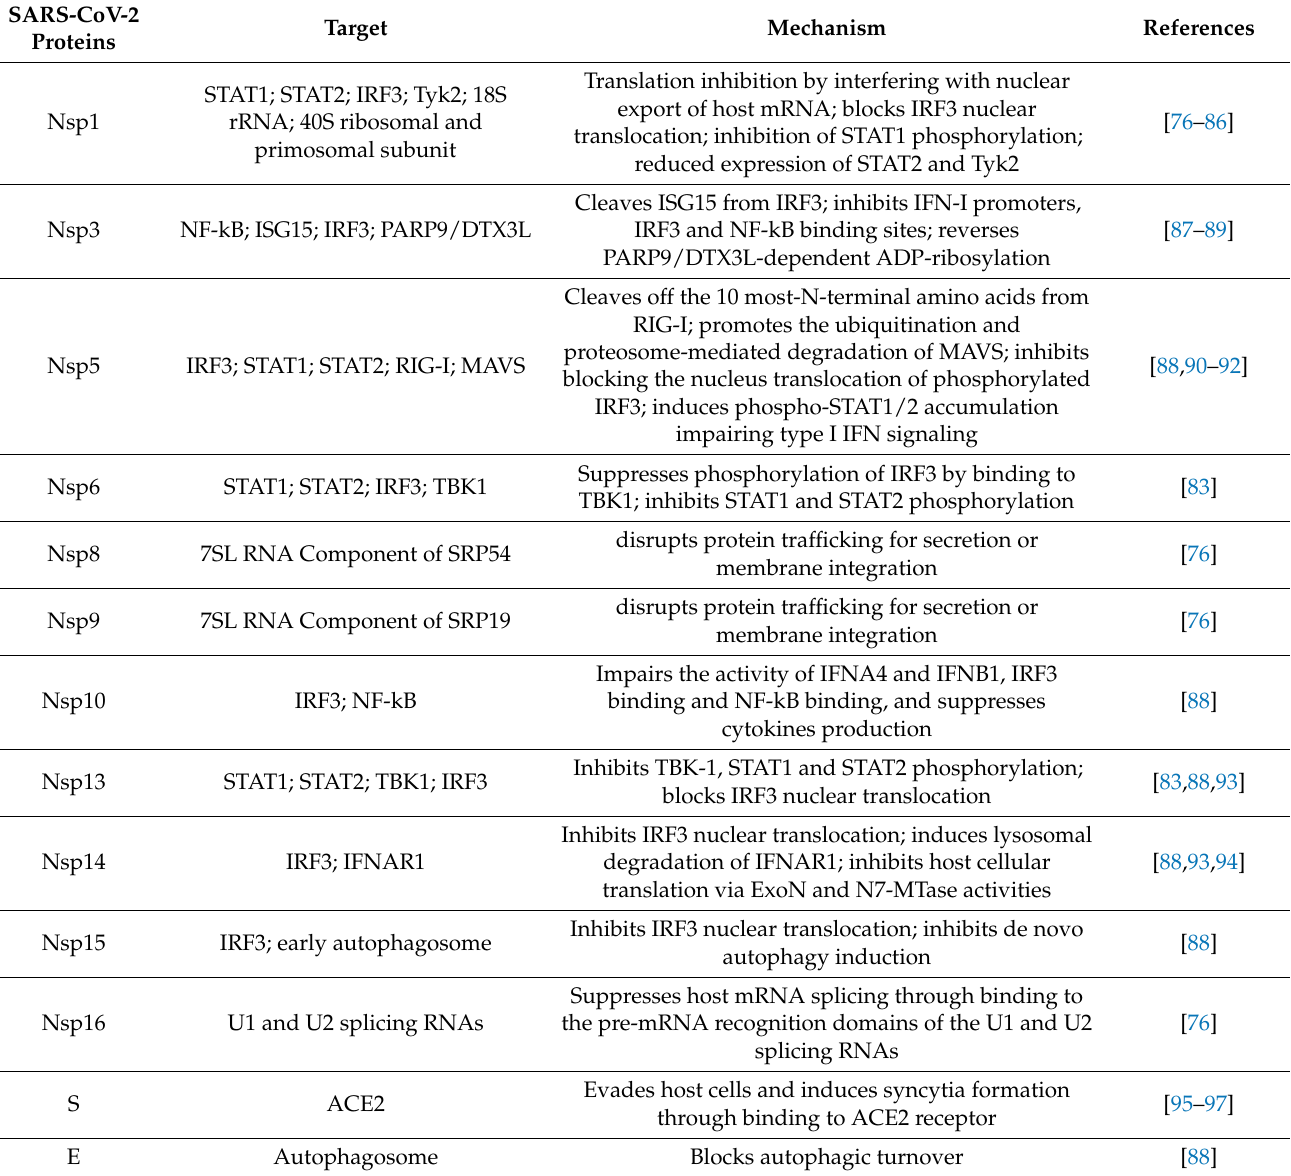
Table 1. Immunosuppressor activity of SARS-CoV-2